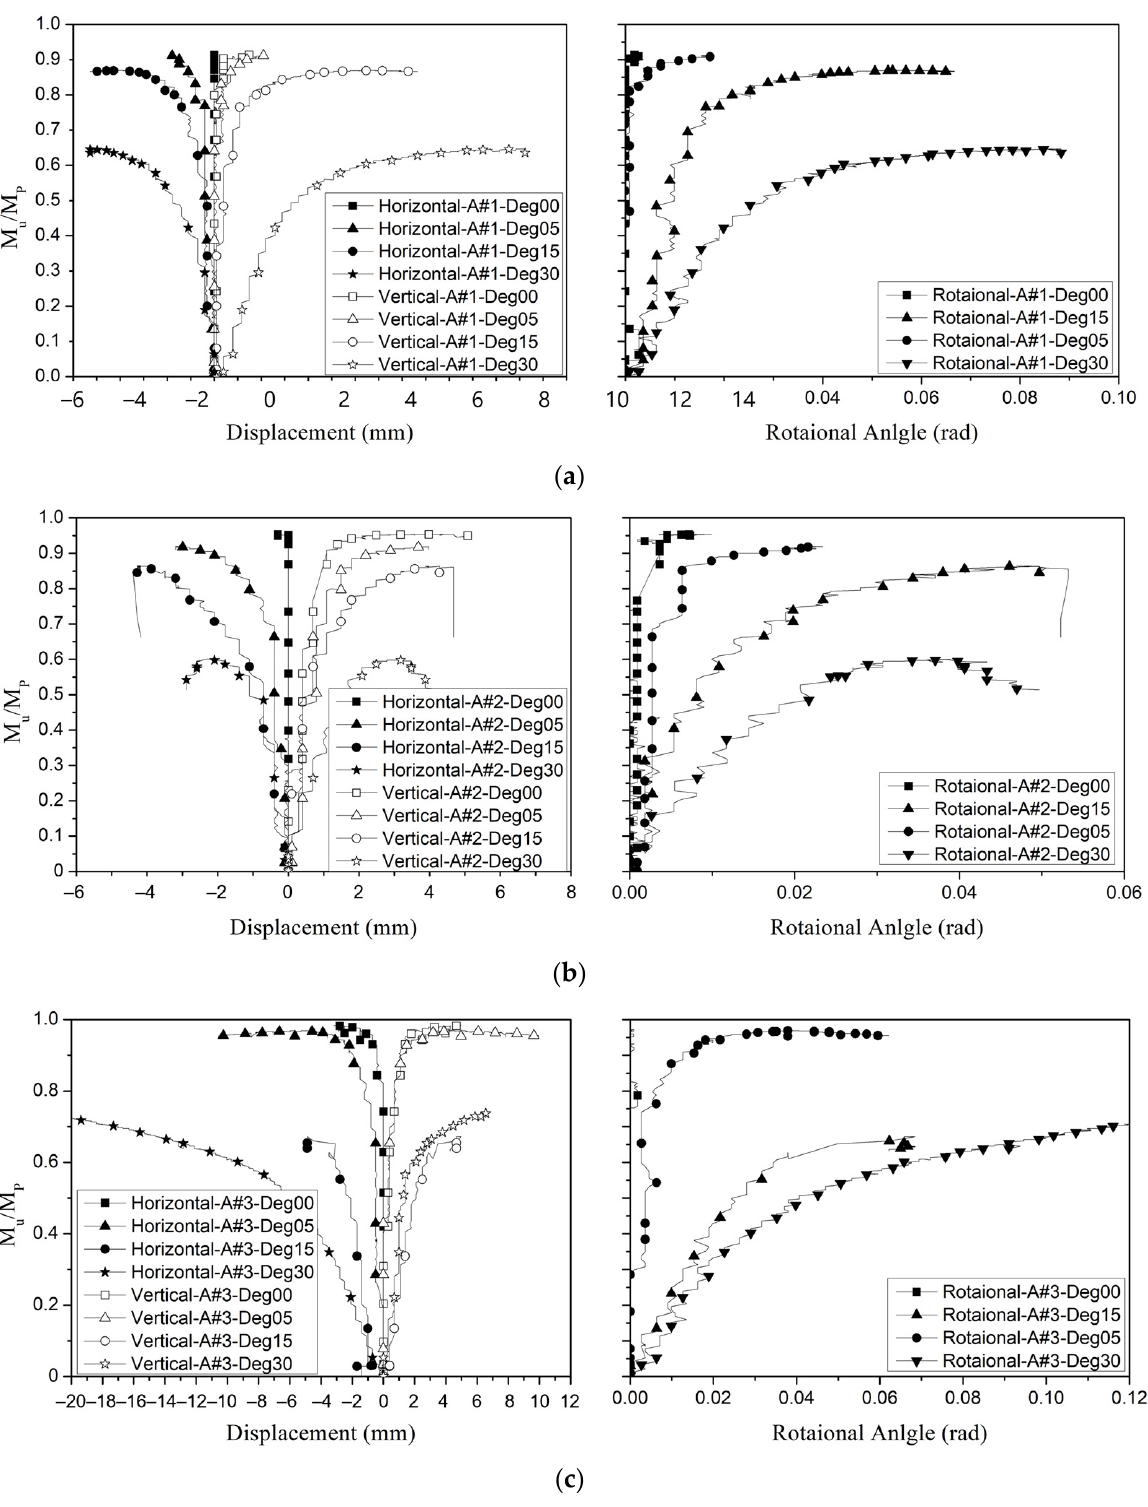
Figure 16. Load-Displacement Curves; ( a ) test specimen Sec-T#1; ( b ) test specimen Sec-T#2; ( c ) test specimen Sec-T#3.